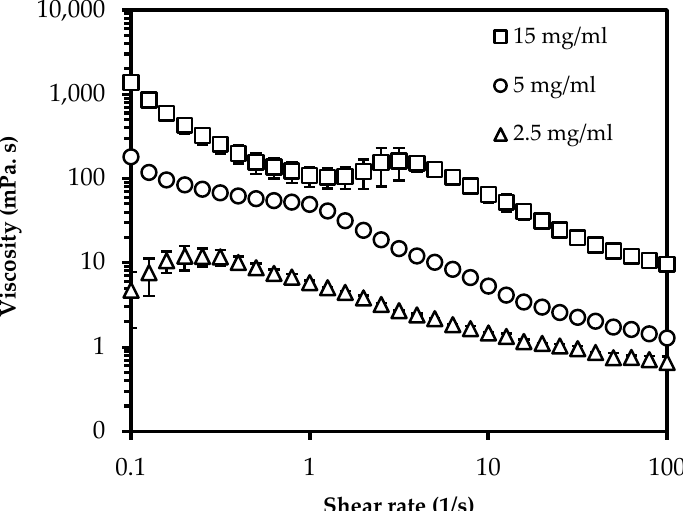
Figure 2. Viscosity of ChNC dispersions as function of shear rate.